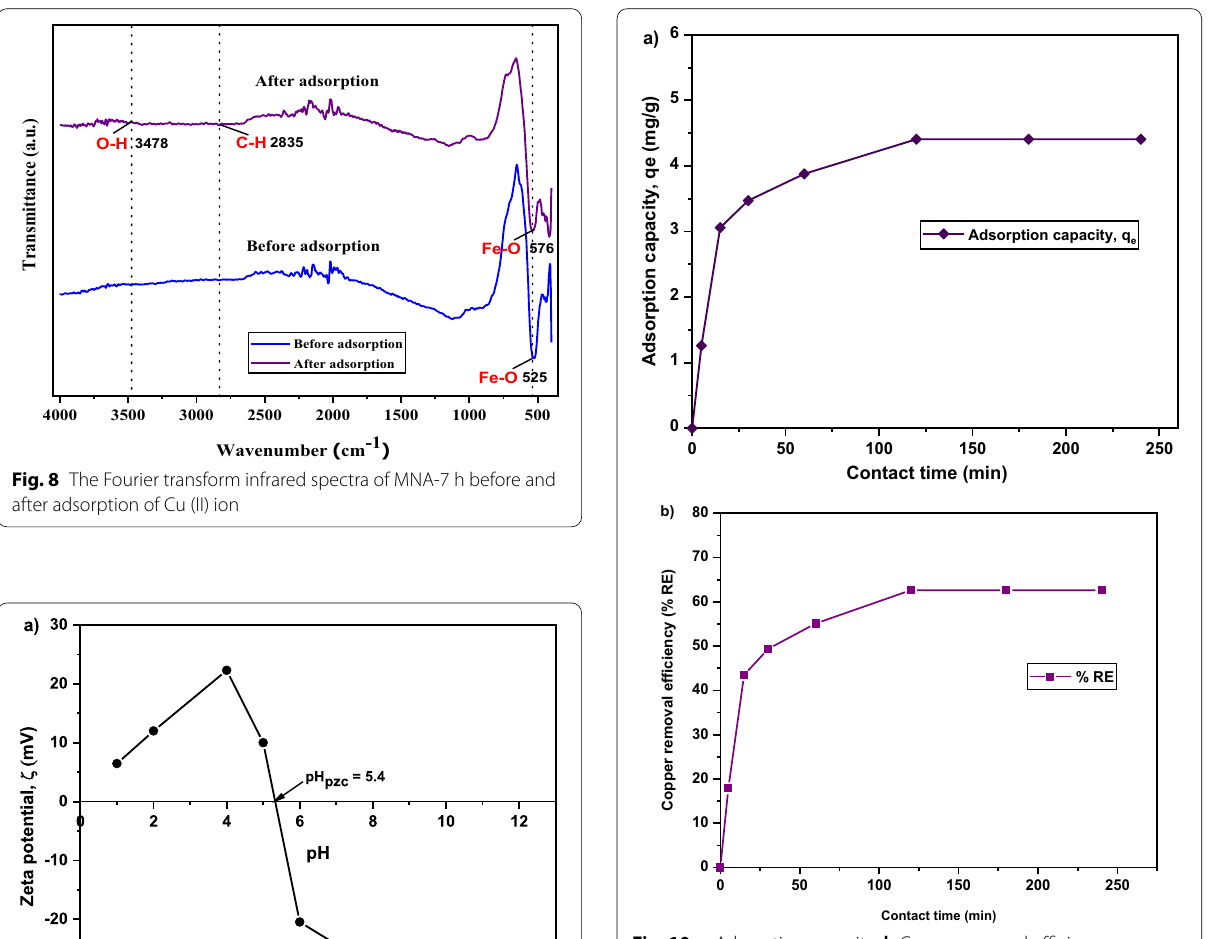
Fig. 10 a Adsorption capacity; b Copper removal efficiency under various contact times of MNA-7 h (metal solution: 200 mL; Table 2 Copper removal efficiency at varied contact time